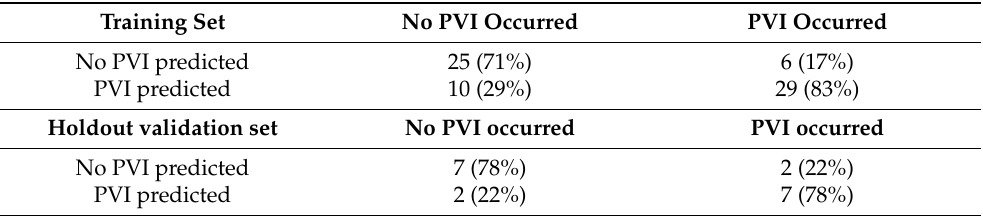
Table 2. Contingency tables of the radiomics model against the ground truth in the training and holdout validation